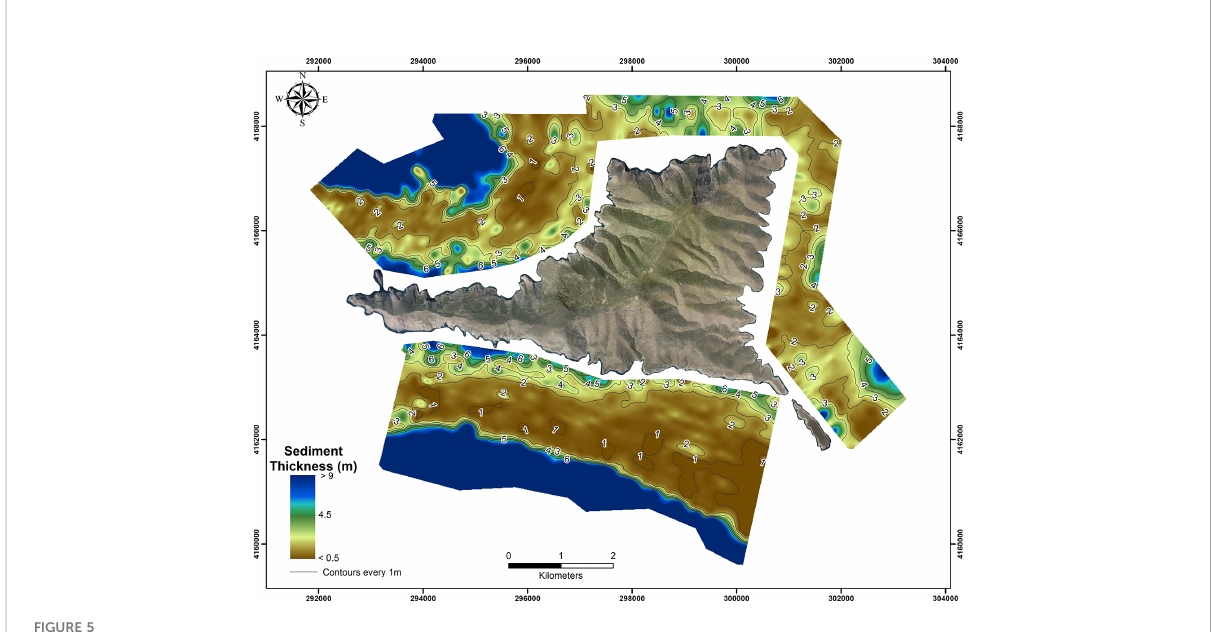
FIGURE 5 Map of the sediment thickness in the